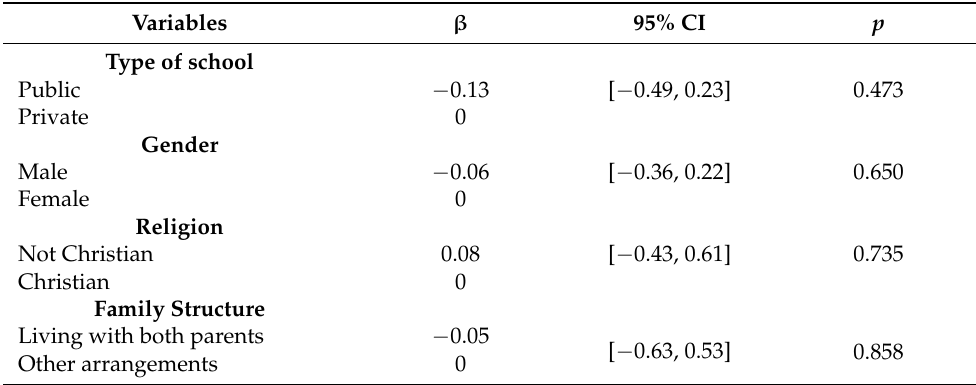
Table 3. Six and 12 months estimated change scores effects on the academic performance of Lebanese